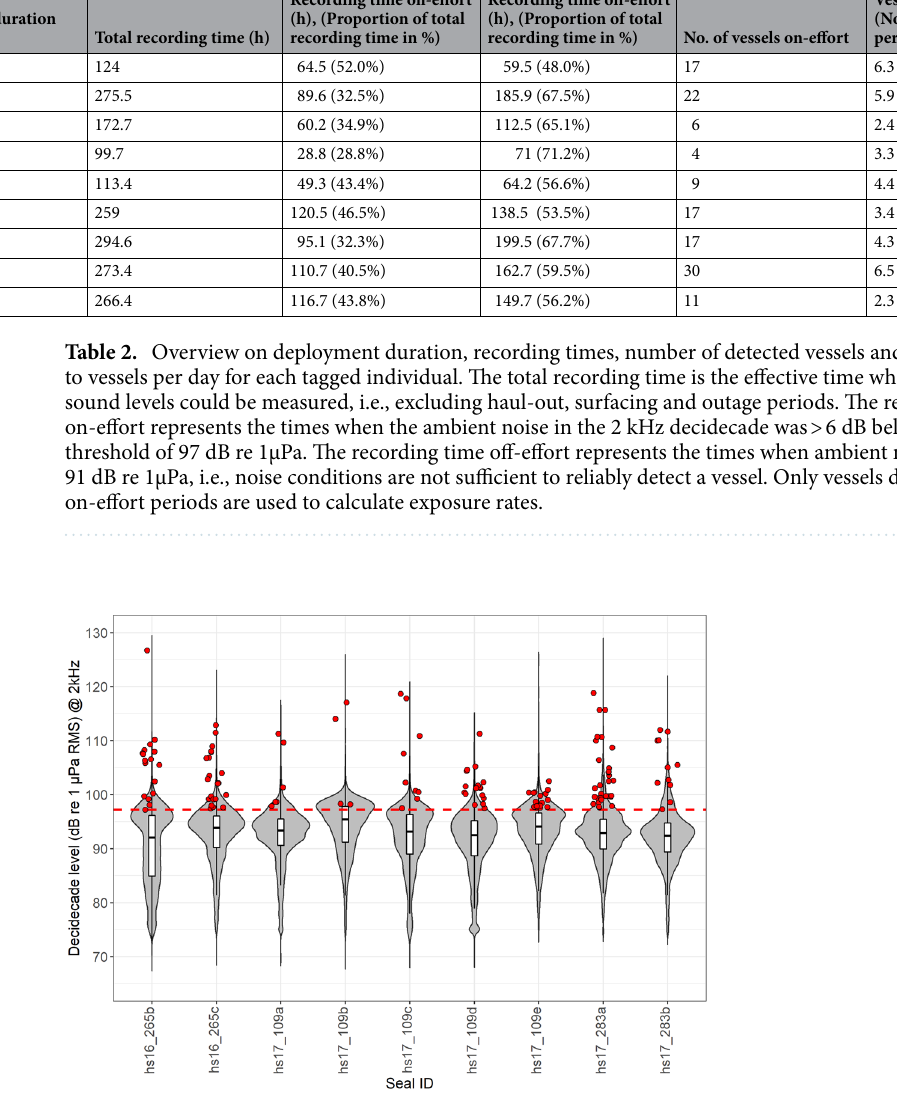
Figure 3. Distribution of 2 kHz decidecade levels (dB re 1 µPa RMS), i.e., the RMS sound pressure level in the 2 kHz decidecade band, for each seal shown as violin plots. The small boxplots within the violins indicate the median and interquartile range of the distributions. The red dashed line illustrates the threshold (97 dB re 1 µPa) for vessel detections. The red points represent the maximum received levels of each vessel pass during on-effort periods (n = 133); the points are randomly spread horizontally to increase